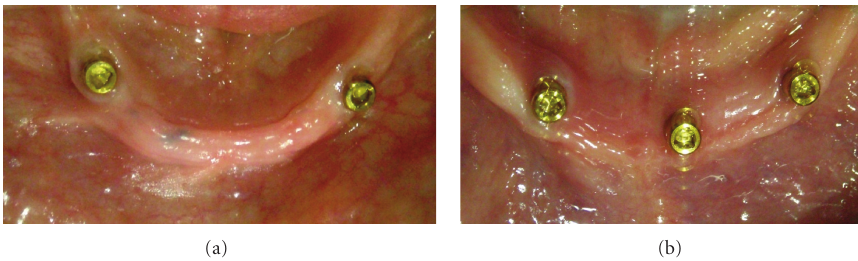
Figure 2: Locator attachments screwed into the implants 10 weeks after their